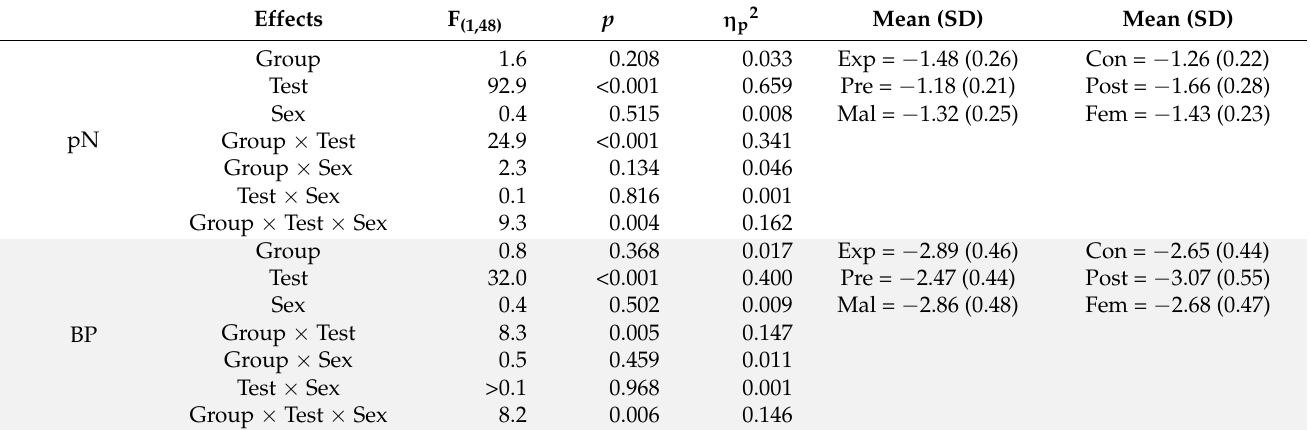
Figure 5. ERP waves at the medial prefrontal and centro-parietal pools of electrodes. The pools are shown in red form in the head flat-view insets. in the − 320 to 0 ms interval (grey area). Table 3. Main effects and the interaction of the ANOVA on the pN and BP components. Mean values are expressed in µ V. See Table 1 for other